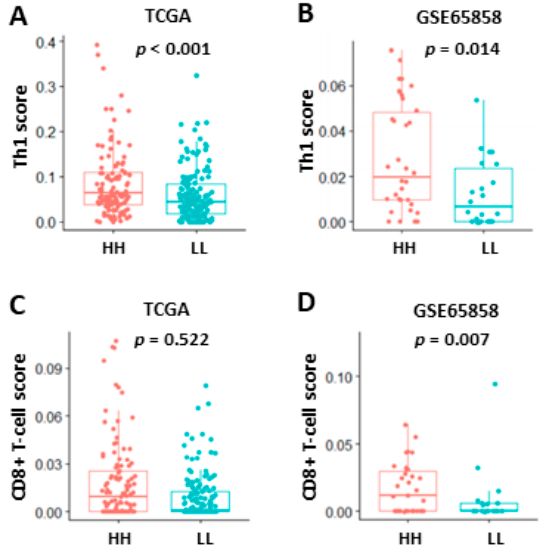
Figure 7. Tumor infiltration of Th1 ( A , B ) and CD8+ T cells ( C , D ) in TCGA ( A , C ) and GSE65858 ( B , D ) oral cancer data sets based on the coordinated expression of CXCL10 and STAT2 (HH vs. LL). The analysis was based on xCell algorithm (https://xcell.ucsf.edu/ (accessed on 4 April 2021). HH, both high. LL, both low.